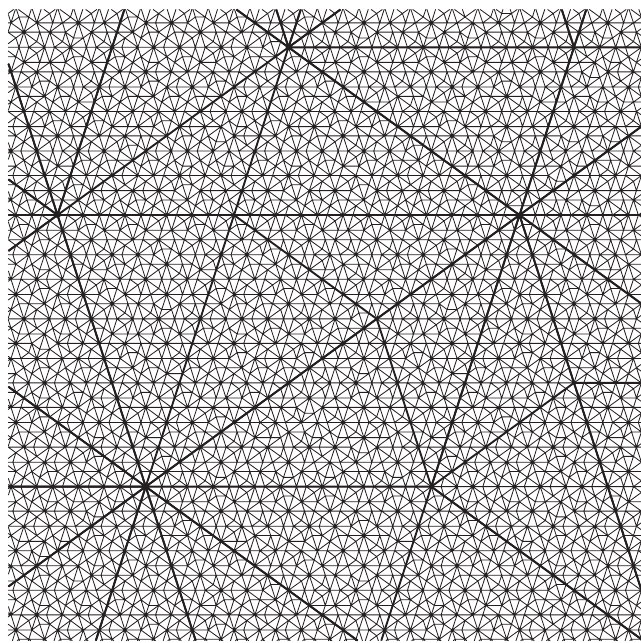
Figure 14: The superposition of Φ 6 − (cid:2) A 1 (cid:3) and Φ 12 − (cid:2) A 1 (cid:3) .